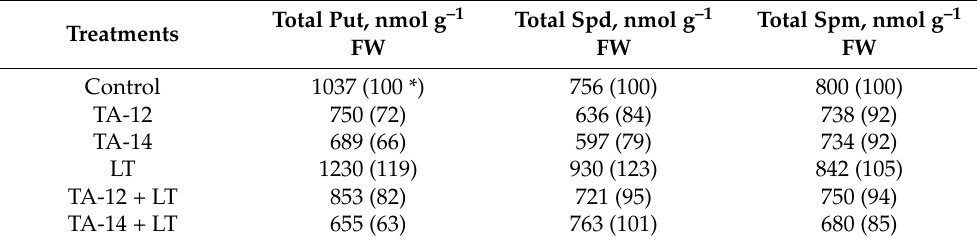
Table 1. Total content of putrescine (Put), spermidine (Spd) and spermine (Spm) in pea sprayed with TA-12 or TA-14 and subjected to low temperature ( − 1 ◦ C, LT) for 24 h. Treatments